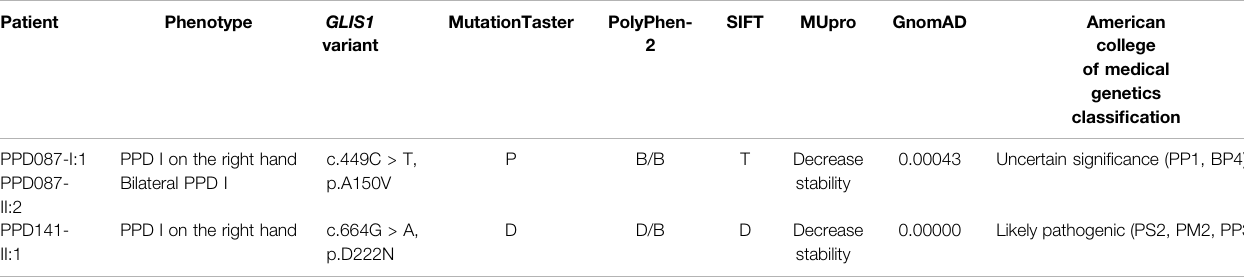
TABLE 3 | Phenotypes and genotypes of PPD patients with GLIS1 (NM_147193) variants. Patient Phenotype